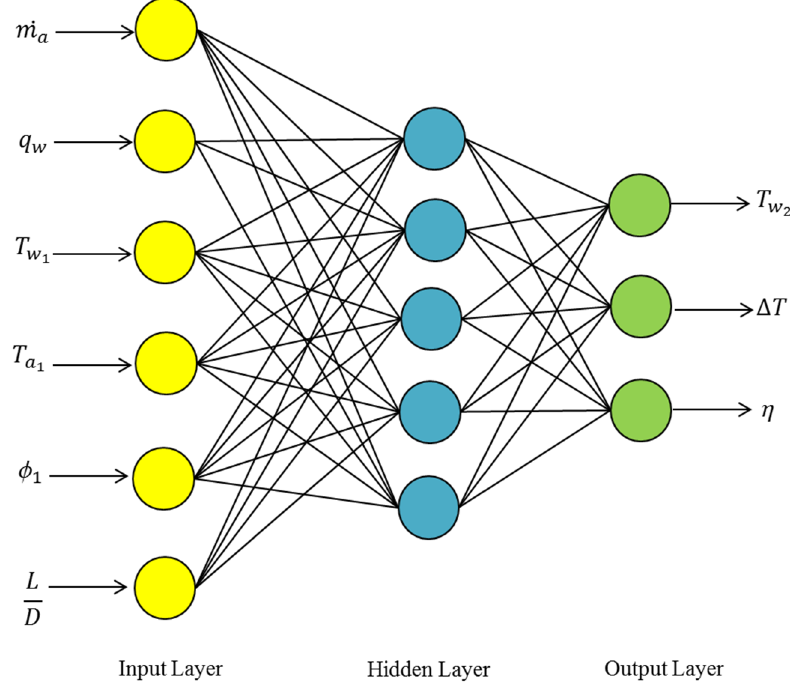
Figure 3. Five-layer neural Figure 3. Five ‐ layer neural network.